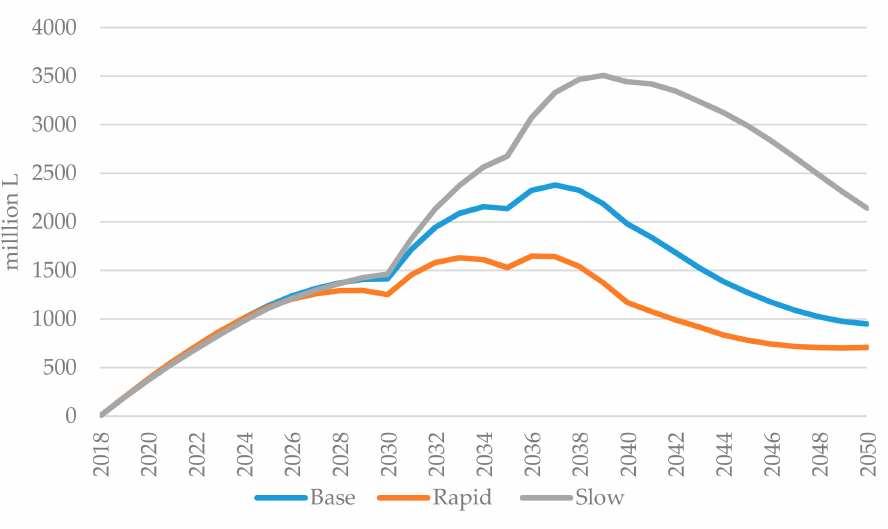
Figure 7. Use of forest-based biofuel in the Nordic countries, by